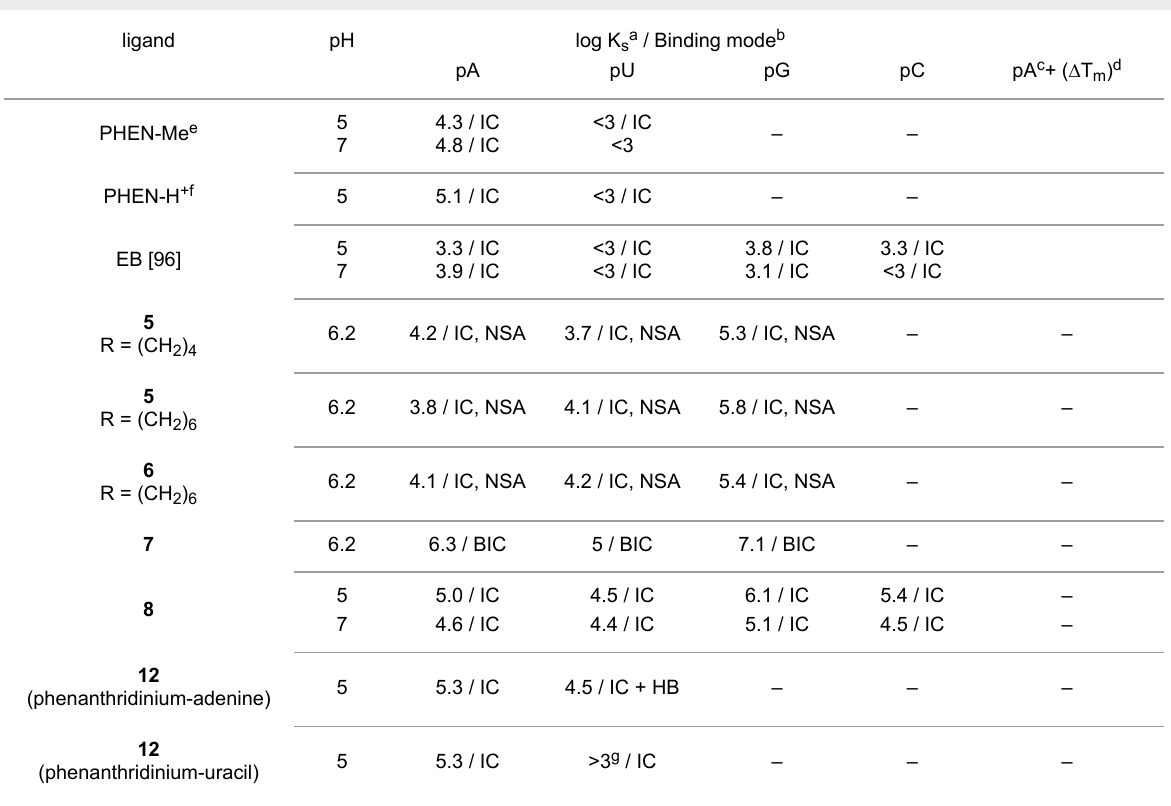
Table 2: Binding affinities (log Ks ) and proposed binding modes of chosen phenanthridine and phenanthridinium derivatives with synthetic polynuc- leotide ss-RNA. ligand pH log K sa / Binding mode b